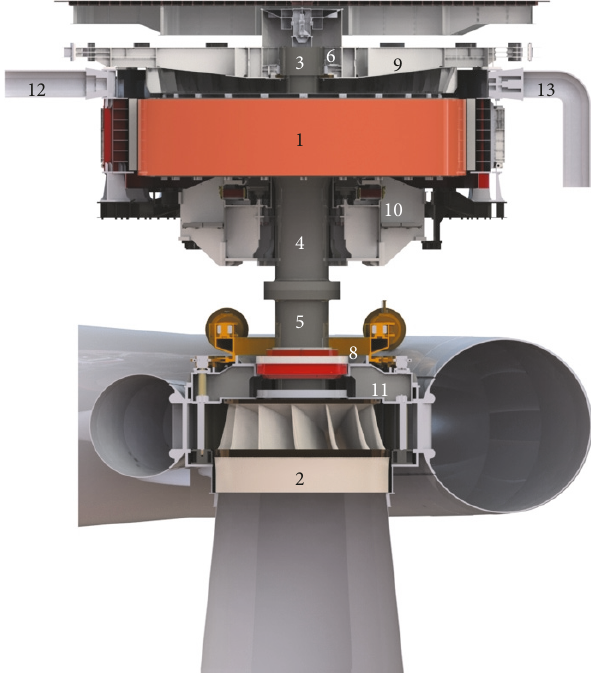
Figure 1: View of Itaipu Power Plant